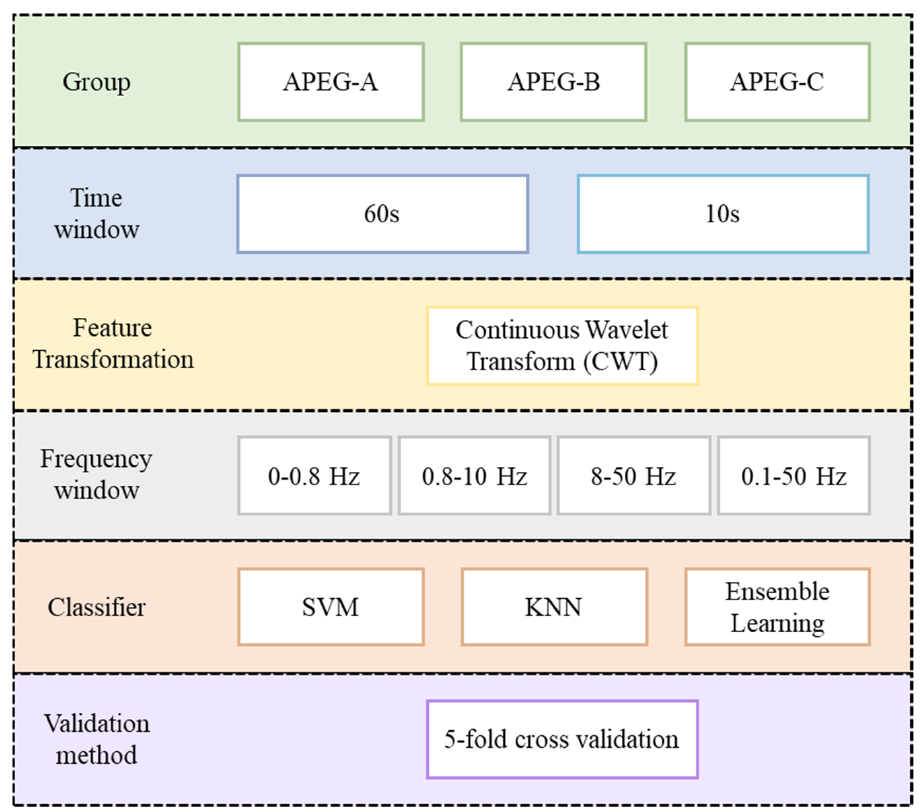
Figure 1. Proposed sleep apnea detection algorithm using machine learning framework and bag -of-features derived from ECG spectrograms (SVM: Support Vector Machine; KNN: k-nearest neigh-bor).